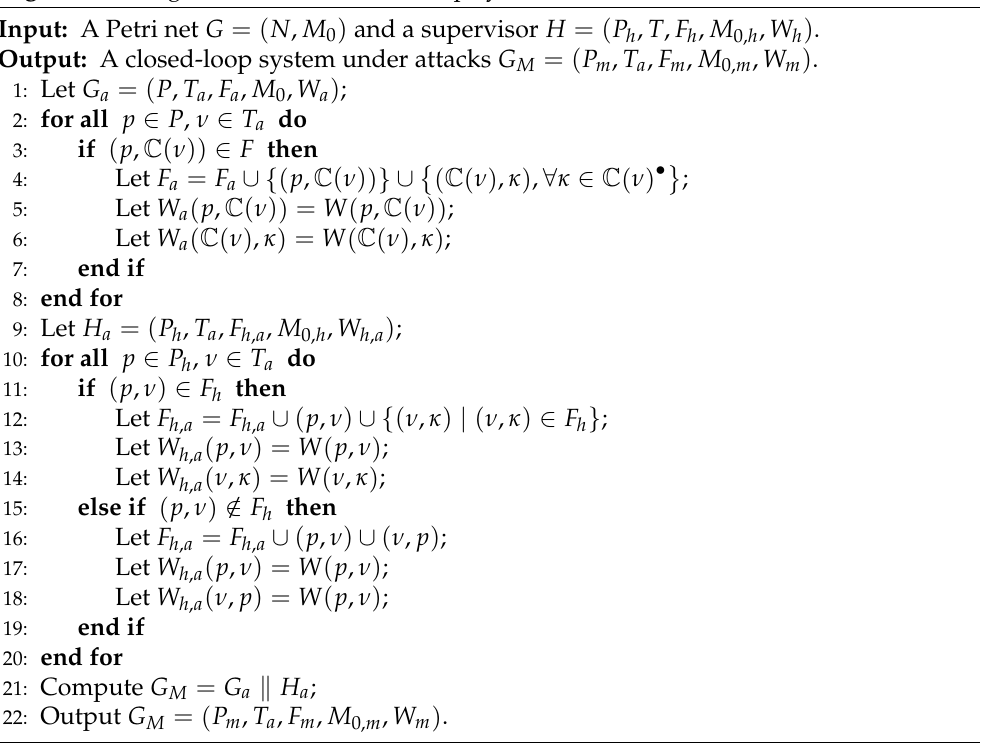
Algorithm 1 Algorithm for the closed-loop system under attacks